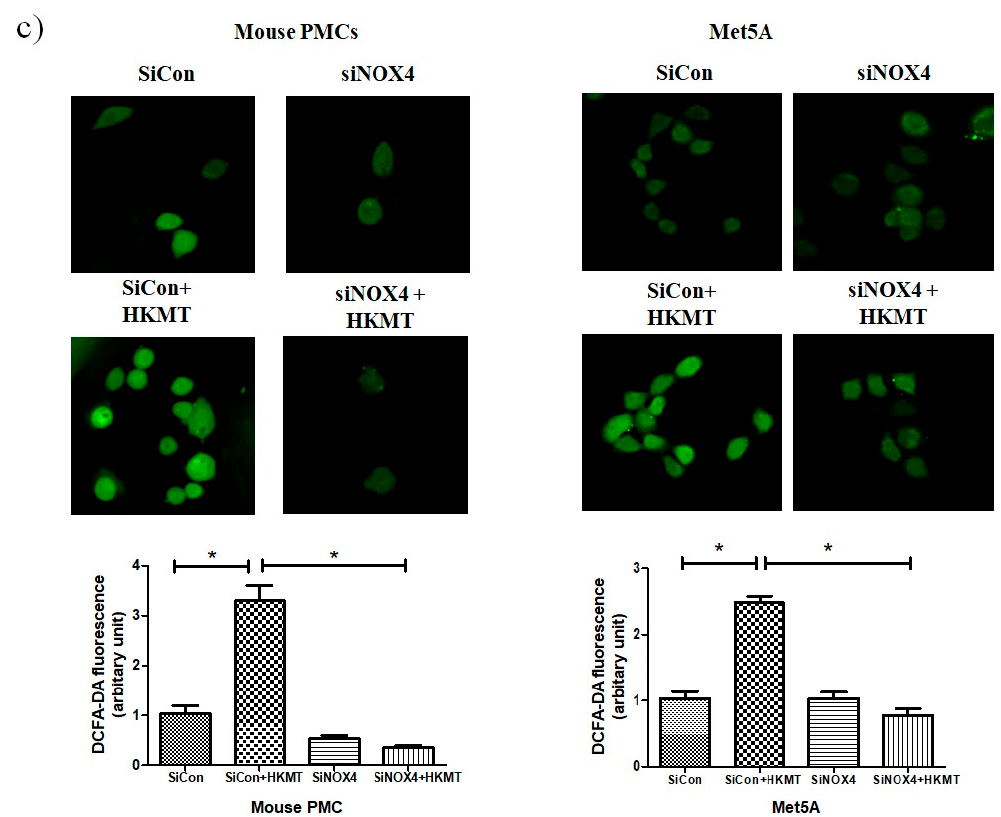
Figure 2. NOX4 mediates HKMT-induced collagen-1A synthesis and EMT. Pleural mesothelial cells were transfected with SiRNA targeting NOX4 (SiNOX4). Twenty-four hours later, the cells were treated with HKMT (10 ng/mL) for 1 h or were left untreated. ( a ) Western blotting analyses of NOX4, phosphorylated ERK, and collagen, and EMT markers. ( b ) COL1A mRNA level by RT-PCR. ( c ) Representative photomicrographs of cells subjected to DCFA–DA treatment. * p < 0.05. Data are expressed as mean ± SD. NOX, NADPH oxidase; EMT, epithelial to mesenchymal transition; COL1A, Collagen 1A. Data are presented as the mean ± SD of three independent experiments.